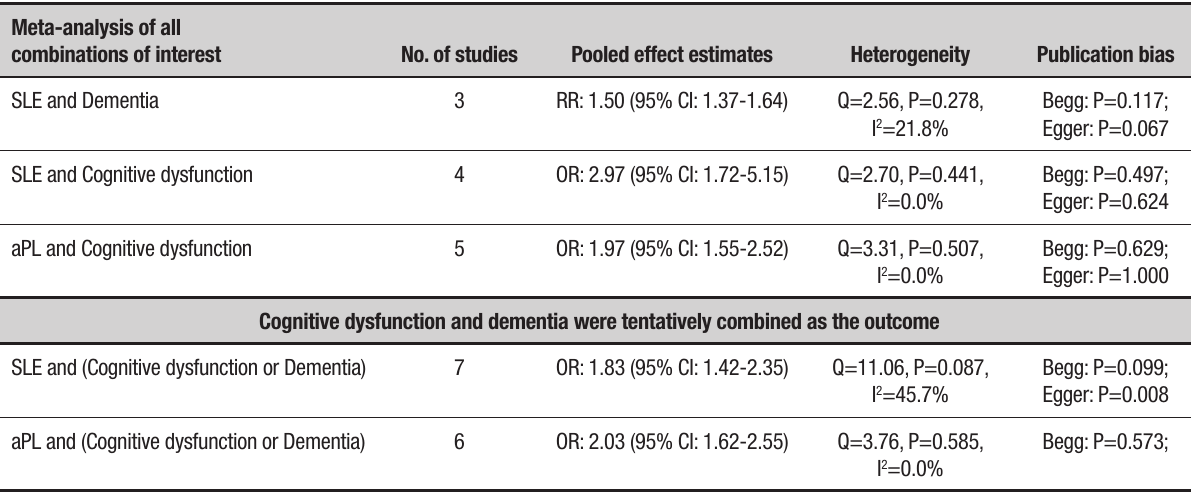
Table 2. Summary of the main meta-analysis for the associations between (SLE or aPL) and (Cognitive dysfunction or Dementia). Meta-analysis of all